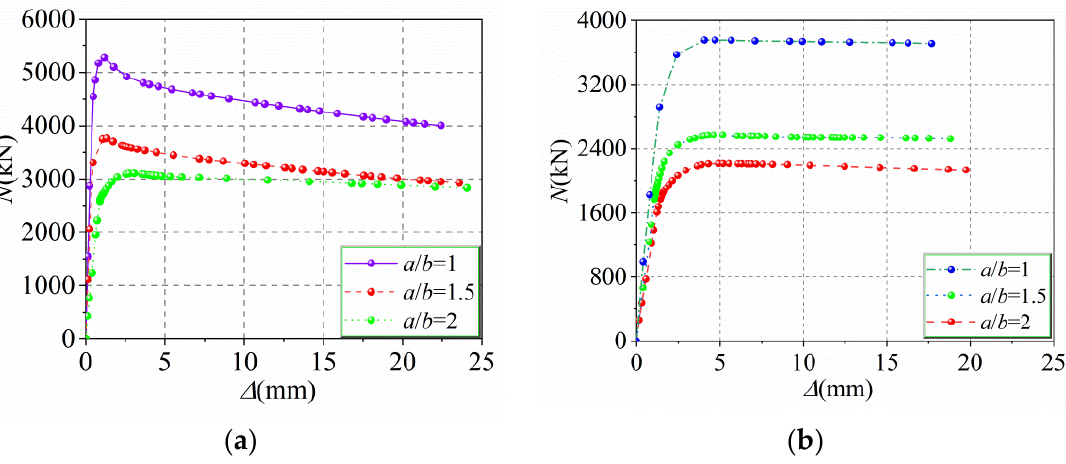
Figure 12. Curves of load–deflection for specimens with various ψ : ( a ) e = 20 mm; ( b ) e = 50 mm.